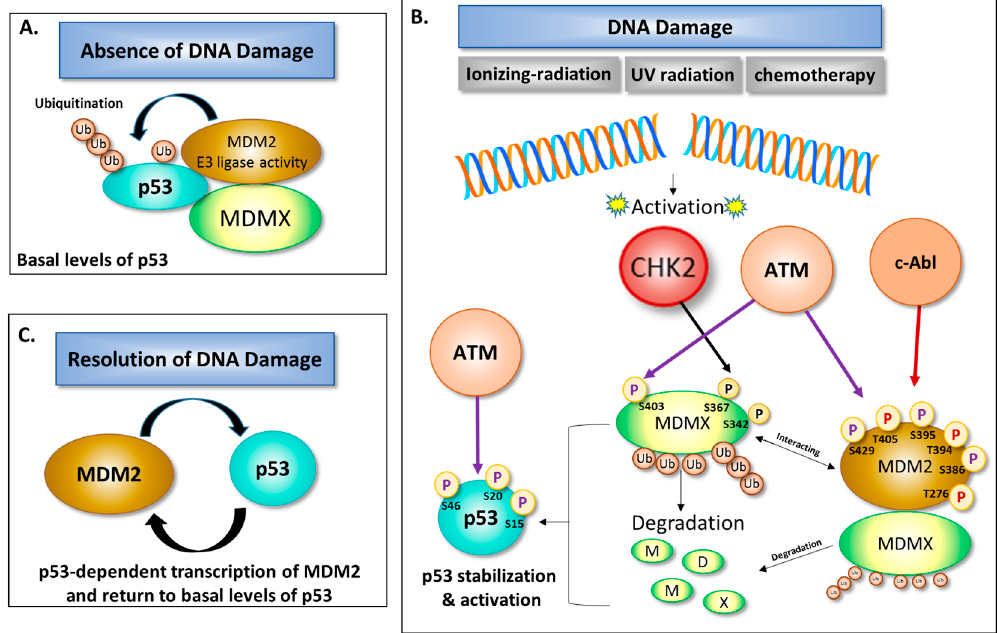
Figure 2. Regulation of p53 by MDM2 and MDMX following DNA damage. ( A ) In the absence of DNA damage, p53 levels and activation are tightly controlled by the MDM2-MDMX complex, and ( B ) upstream kinases act as sensors of DNA damage to regulate MDM2, MDMX, and p53; ( C ) Upon resolution of DNA damage, the p53/MDM2 feedback loop controls p53 levels. Ub = ubiquitin, P = phosphorylation site (purple arrow = phosphorylation by ATM; red arrow = phosphorylation by c-Abl; black = phosphorylation by CHK2); S = serine, and T= tyrosine.